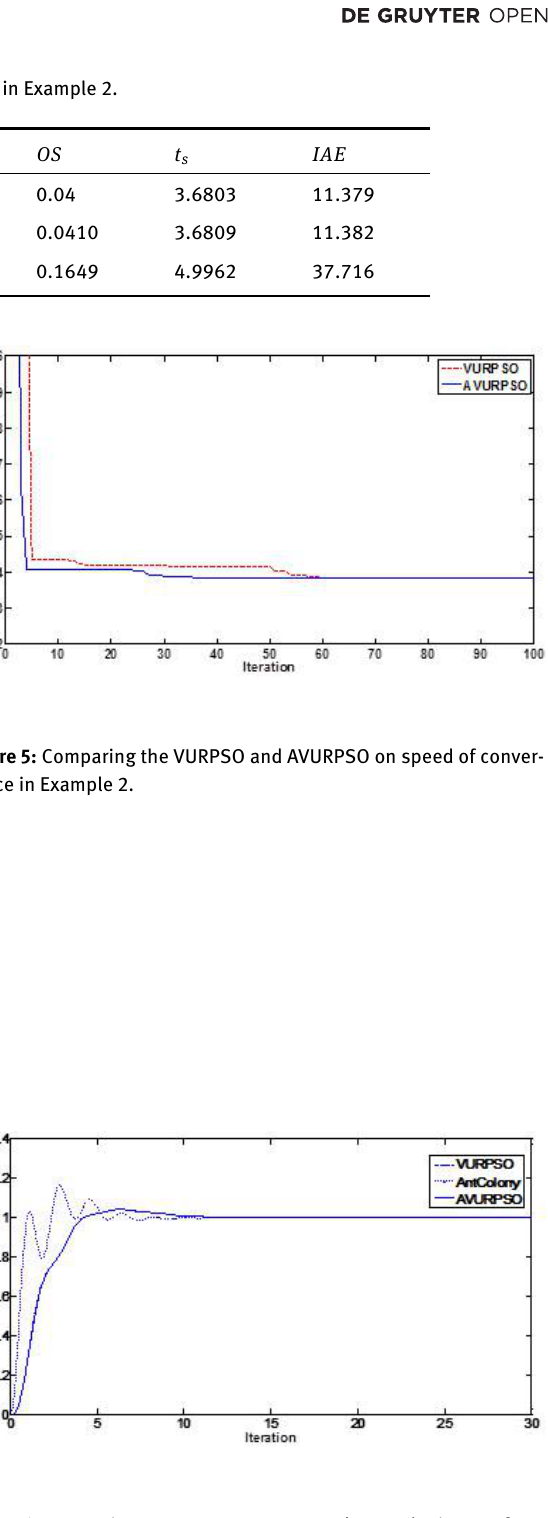
Figure 6: Comparing VURPSO, AVURPSO, and Ant Coloni on perfor- mance of control in Example